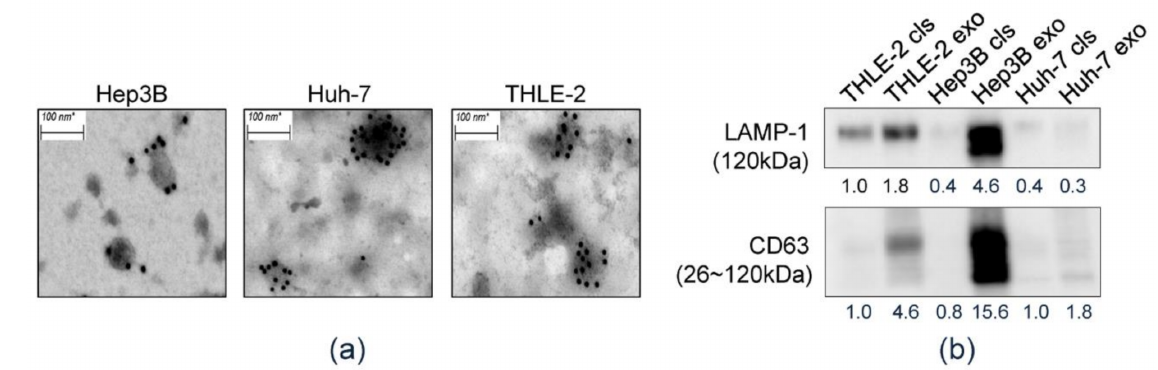
Figure 1. Characteristics of exosomes in liver cell lines. ( a ) Transmission electron microscopic (TEM) images of purified exosomes with 10 nm gold-conjugated anti-CD63 antibody derived from the Hep3B, Huh-7, and THLE-2 cell lines. ( b ) Identifying expression of exosome markers by Western blot